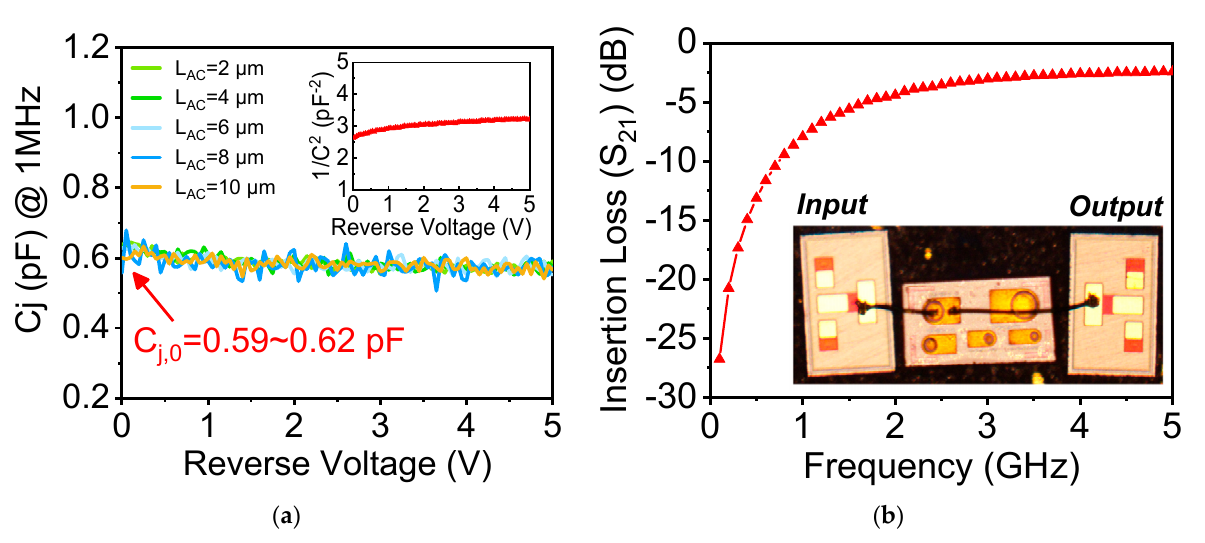
Figure 5. ( a ) C-V characteristics of the GaN SBD at a measurement frequency of 1 MHz with an anode radius of 30 μ m and different L AC of 2, 4, 6, 8, and 10 μ m. Inset is the corresponding C − 2 -V plot. ( b ) Insertion loss (S 21 ) of the GaN SBD over a frequency range of 0.1 GHz to 5 GHz in the small-signal S-parameter measurements. Inset is the wire-bonded GaN SBD with two GSG test fixture modules.